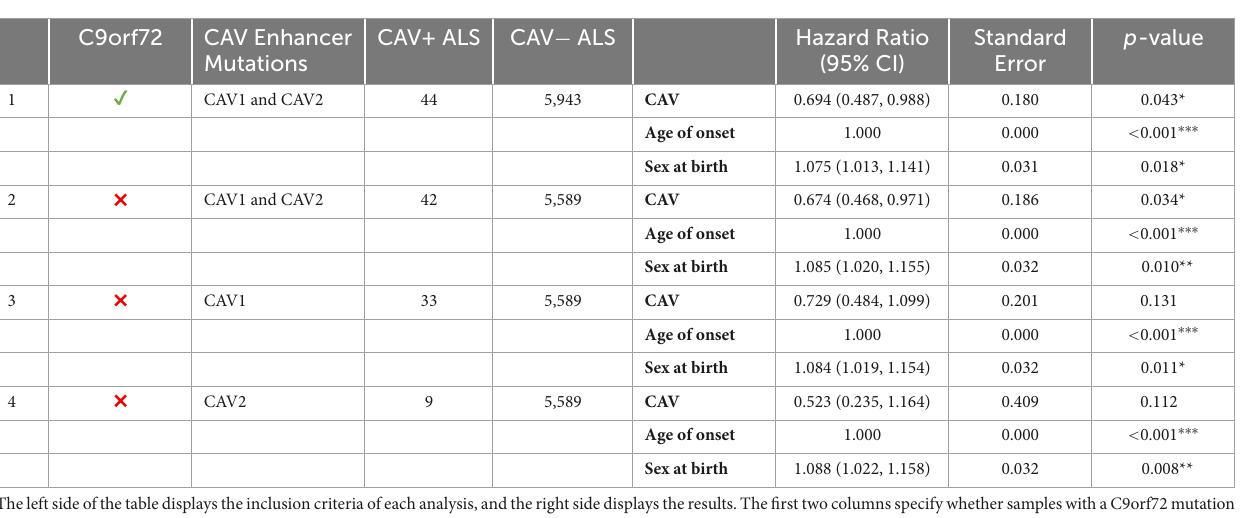
TABLE 4 Breakdown of results across four survival analyses.